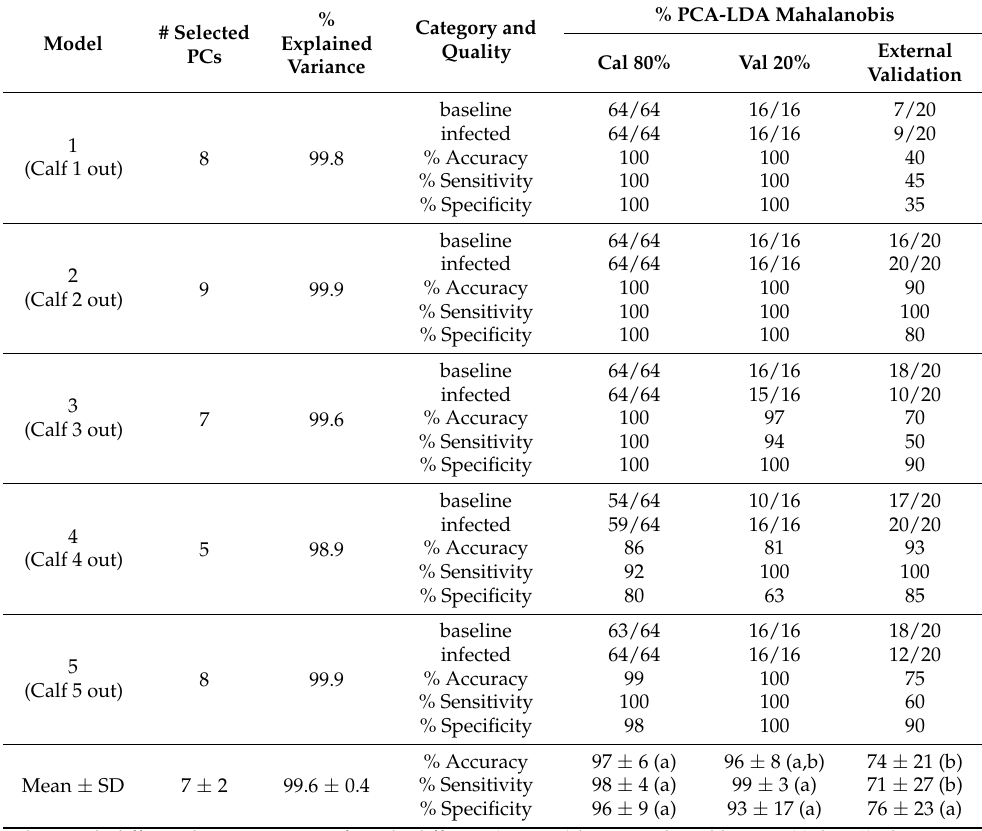
Table 1. PCA-LDA for transformed absorbance (1300–1600 nm) classification and quality parameters for bovine EBC collected before and after the BRSV challenge.